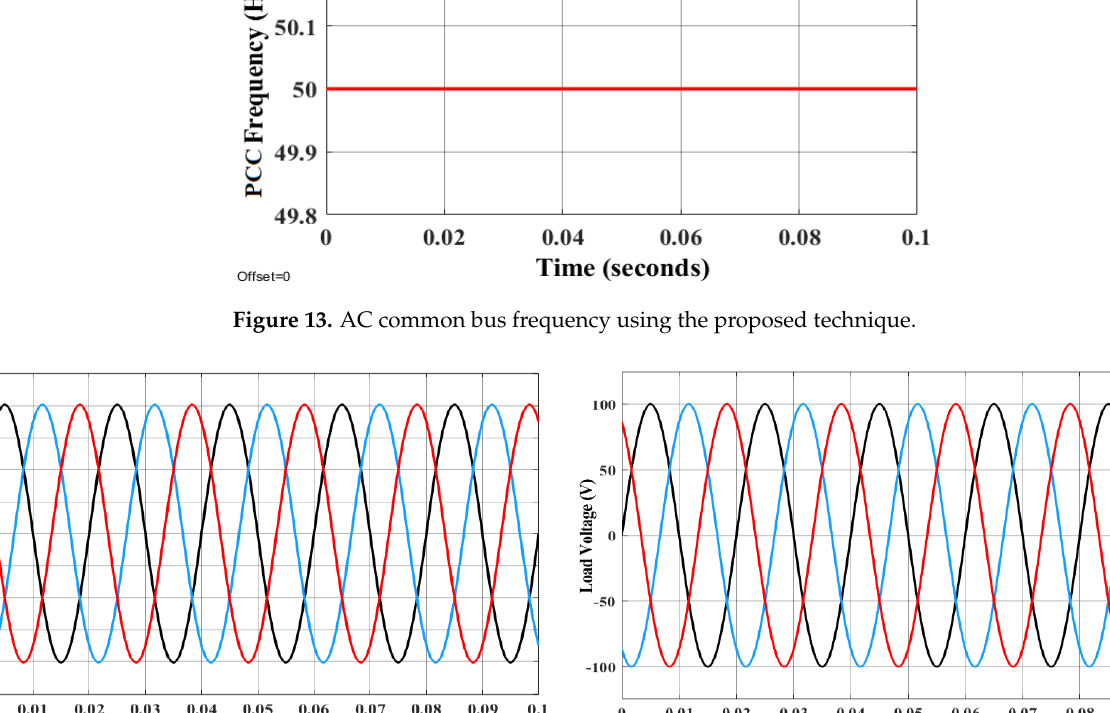
Figure 14. AC common bus current and voltage using the proposed technique: ( a ) current and ( b ) voltage signal.